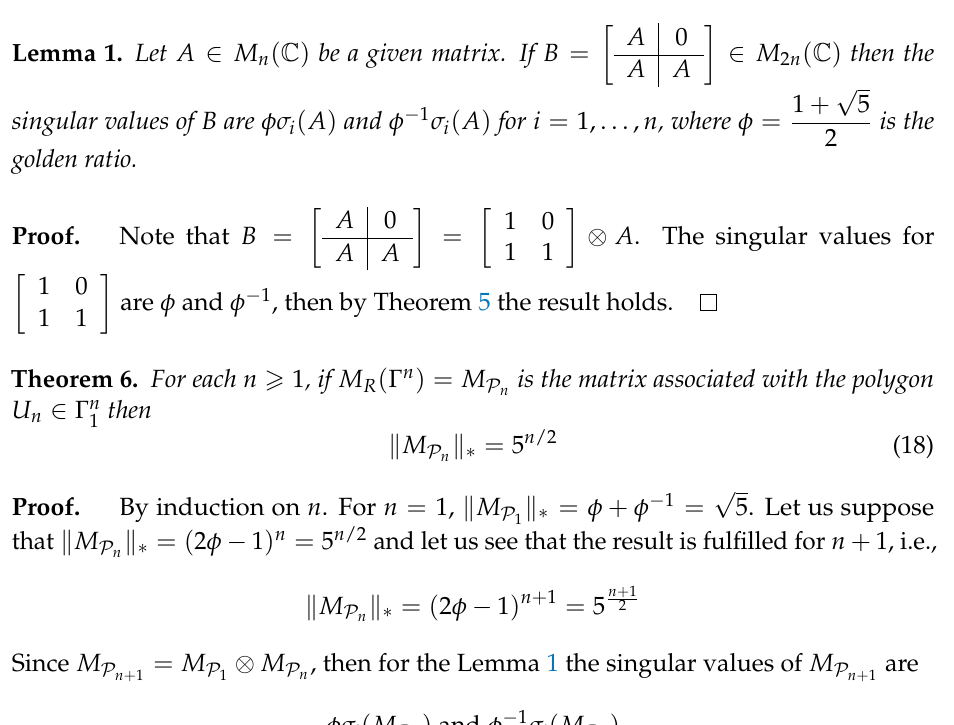
for n = 1,2,3 and n